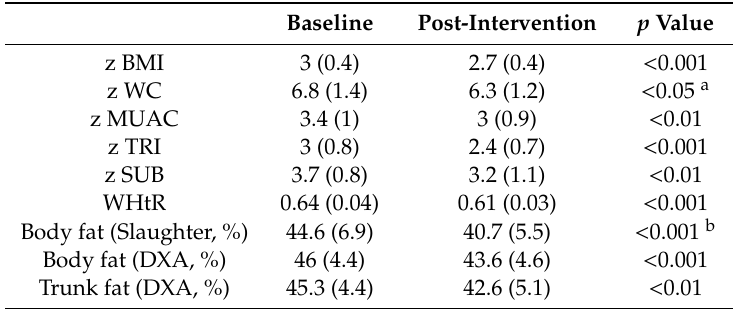
Table 2. Evolution of the anthropometric measurements expressed as mean (SD).